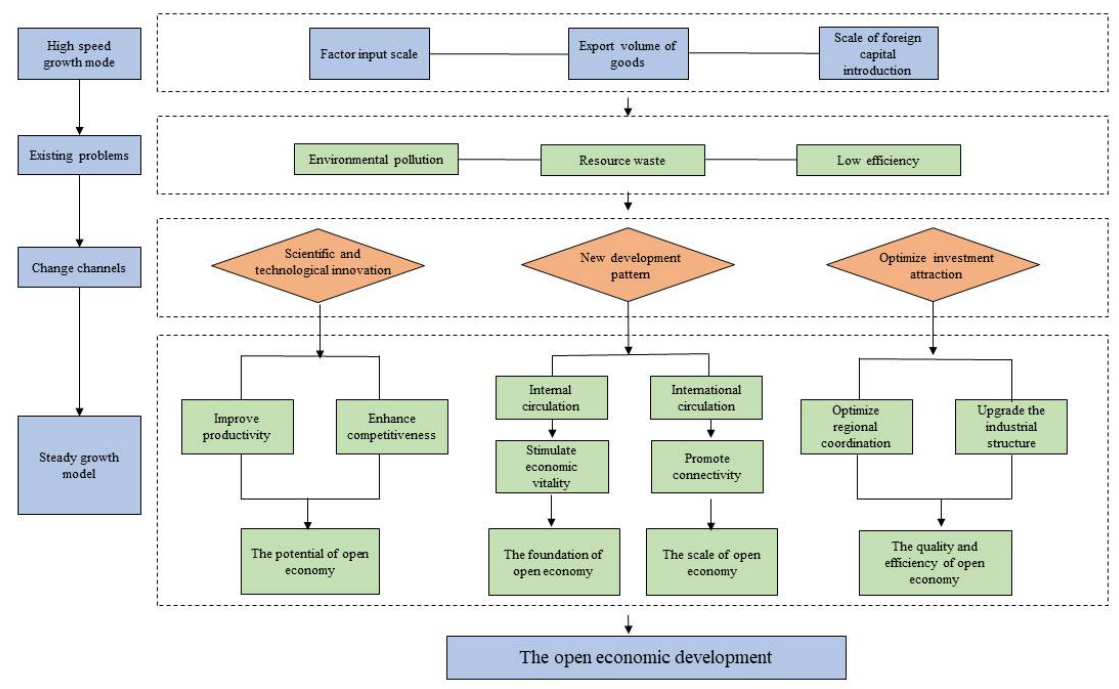
Figure 1. Mechanism map for the development of the open economy.